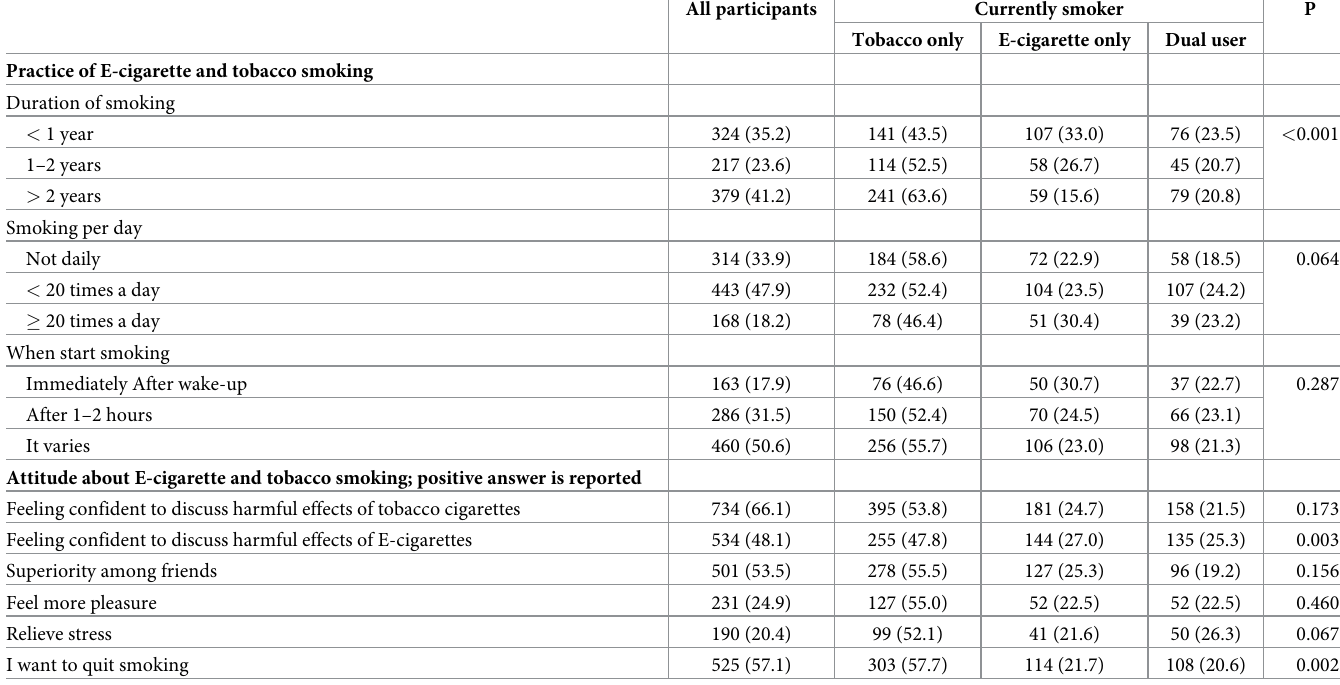
Table 3. E-cigarette use and tobacco smoking practice and attitude by participants (N =